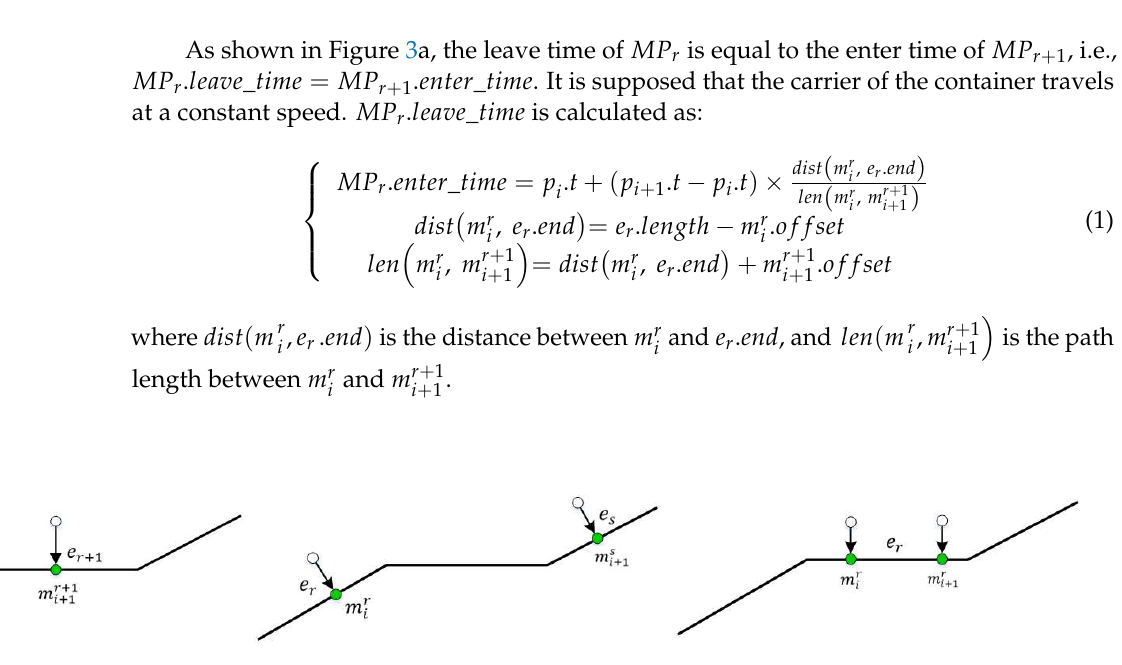
i +1 and m s are separated by multiple road segments; ( c ) m r i i + 1